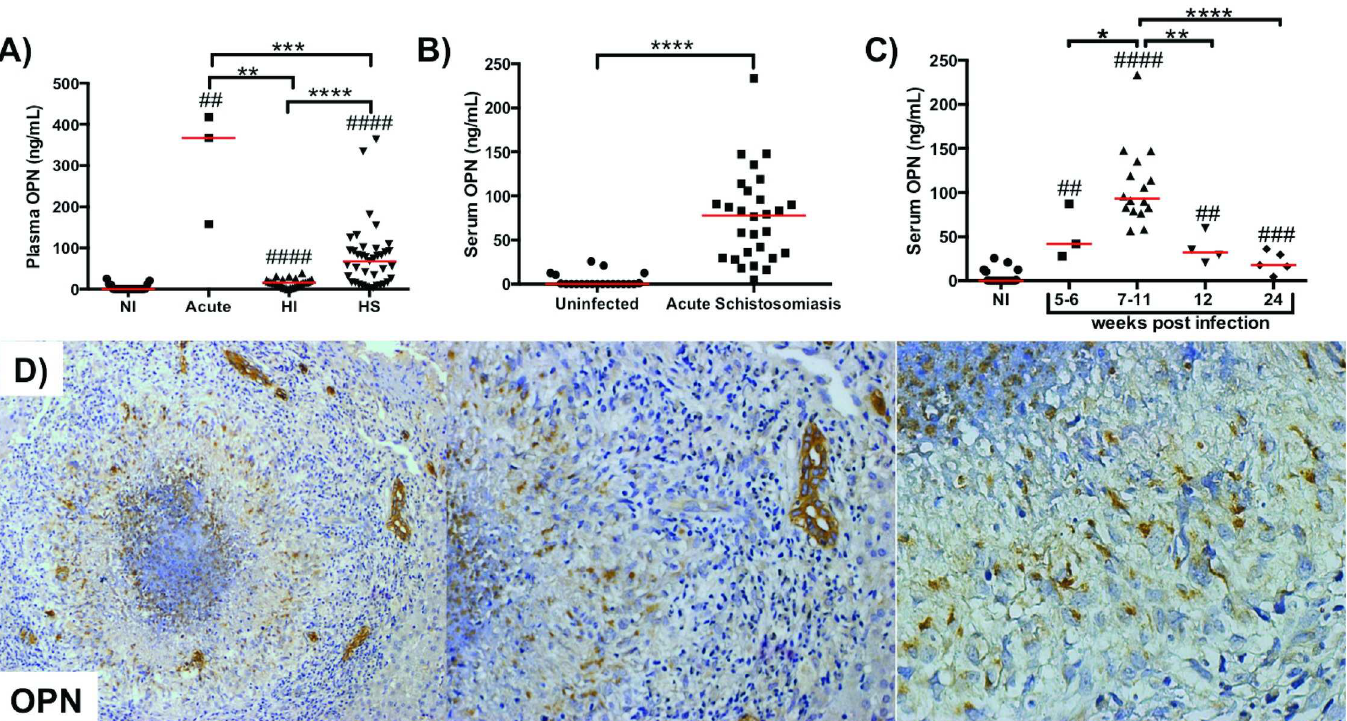
Fig 1. Sera and hepatic osteopontin are upregulated in human acute schistosomiasis mansoni. A) ELISA for osteopontin in the plasma of uninfected controls (NI, n = 21) and schistosomiasis patients with Acute (n = 3), hepatointestinal (n = 26) and hapatosplenic (n = 39) forms of disease. B) ELISA for osteopontin in the serum of uninfected controls (n = 21) and patients with acute schistosomiasis mansoni (n = 28). C) ELISA for osteopontinin the serum of uninfectedcontrols (NI, n = 21) and patients with acute schistosomiasis mansoni (n = 28) groupedby weeks post infection. Medians are displayed; Mann- Whitney U test: #p < 0.05, ##p < 0.01, ###p < 0.001, ####p < 0.0001 vs uninfectedcontrols; * p < 0.05, ** p < 0.01, *** p < 0.001, **** p < 0.0001. D) Immunohistochemistry for osteopontin in liver needlebiopsy fragment of a representative subject with acute schistosomiasis mansoni (10 weeks post infection). Final magnification100x, 200x and